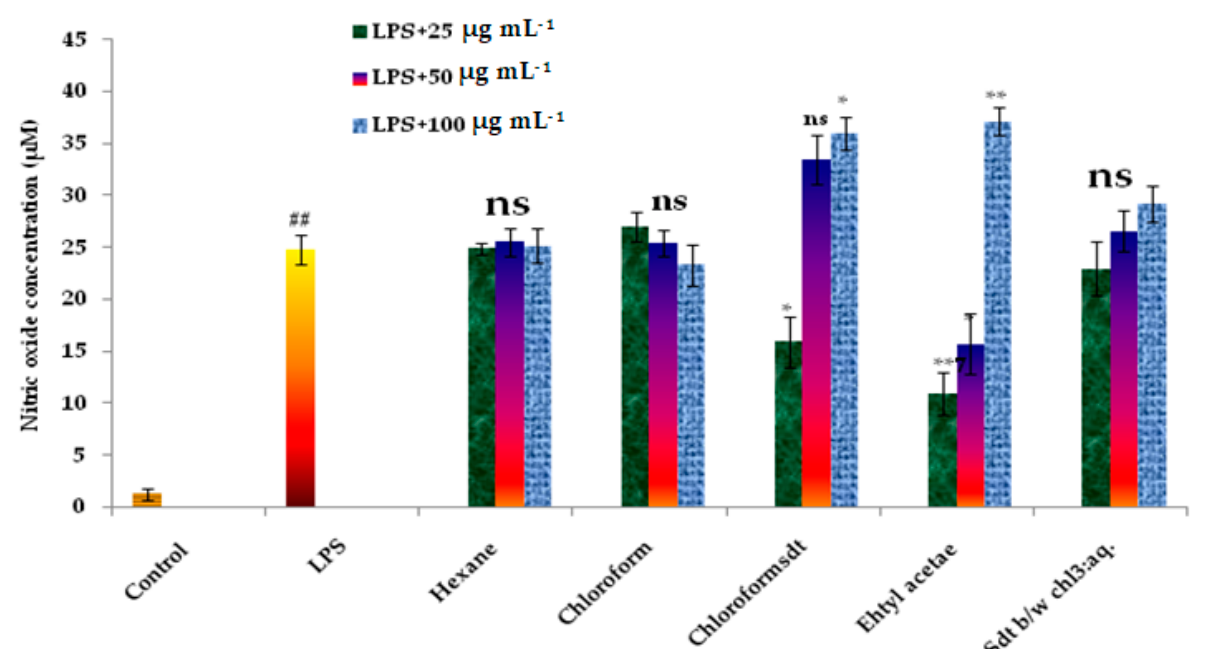
Figure 2. Effect of various fractions based on polarity on LPS-stimulated RAW 264.7 cells. Cells in 96-well plates (1 × 106 cells/well) were first incubated with and without specified concentrations of crude extracts for 2 h, and then incubated with LPS (10 µ g mL − 1 ) for 20 h. ## LPS treated. Untreated is the negative control without LPS treatment. Each value was expressed as mean ± SEM in the triplicate experiment. ns: non-significant, n = 3, data ± S.E.M. Groups 3–7 were compared against group II using Dunnett’s post-hoc test (* significant at < 0.01; ** significant at < 0.001).